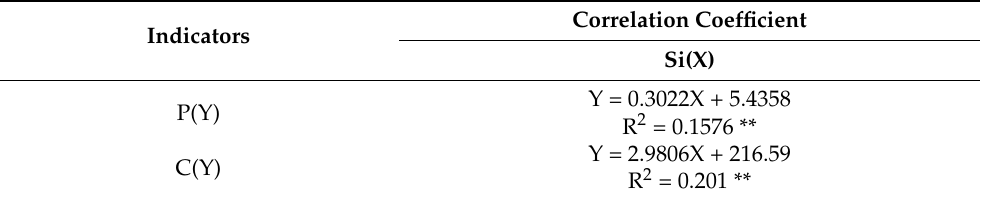
Table 2. Correlation analysis between soil available Si, water soluble P, and water soluble C in